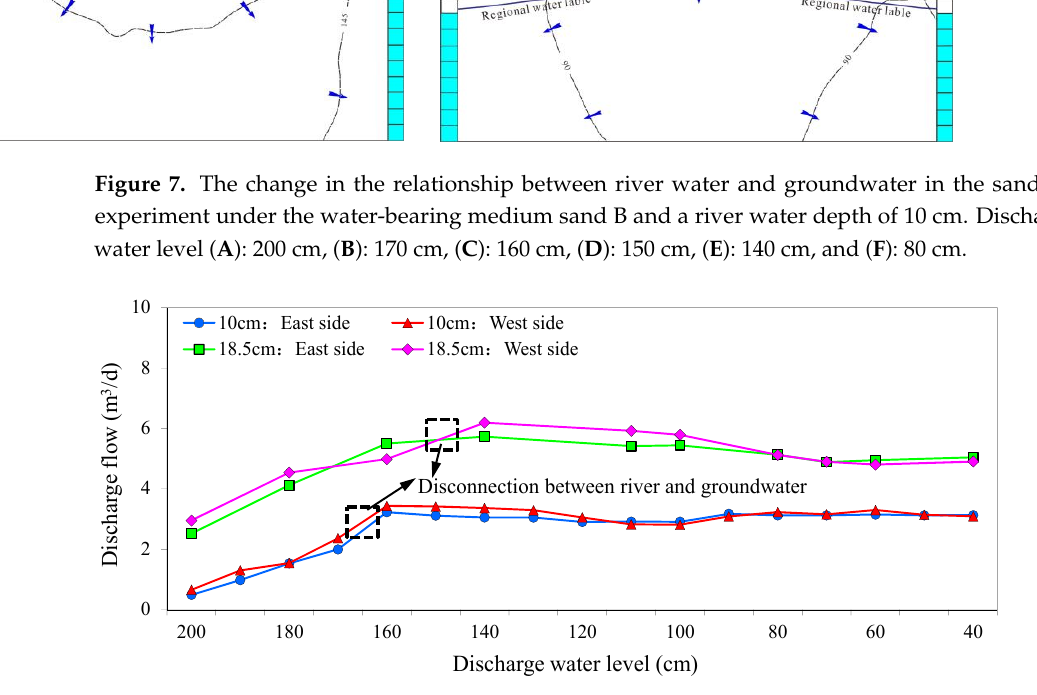
Figure 8. The relationship between discharge flow and discharge water level and river water depth under the water-bearing medium sand B.